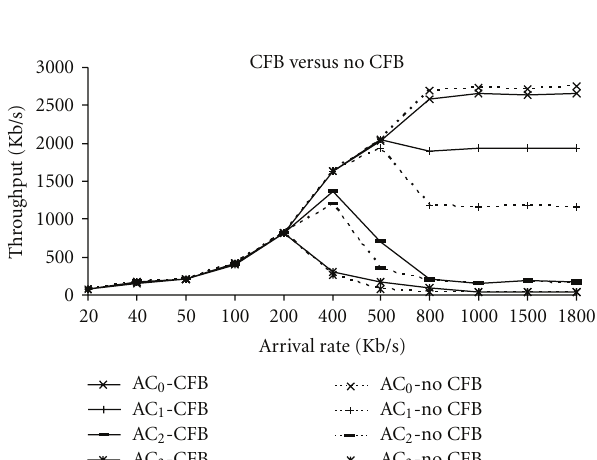
Figure 2: Simulation topology.